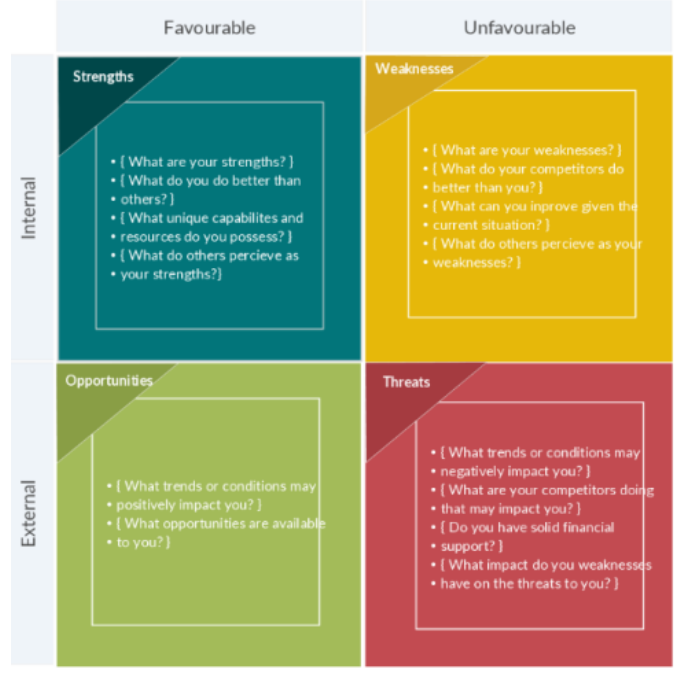
Fig. 7. SWOT Analysis Template